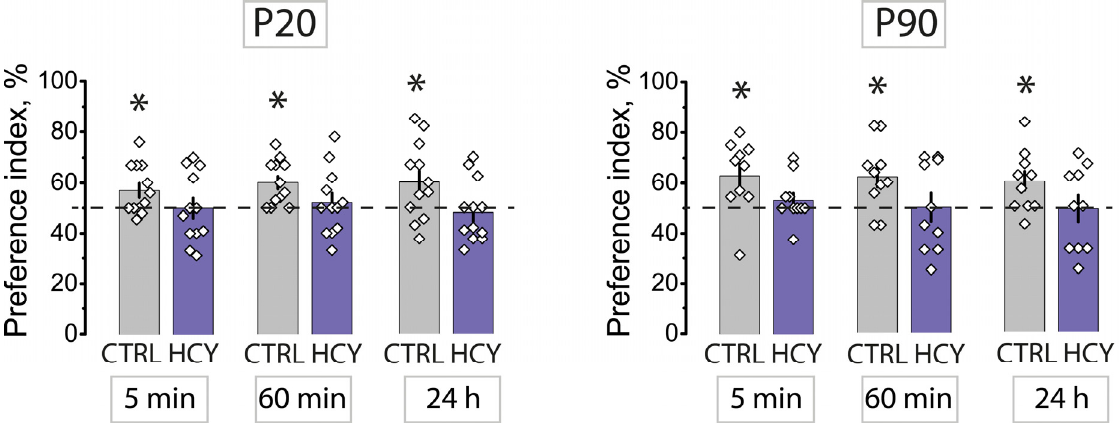
Figure 1. Diagrams showing preference index (PI) for novel objects in young (P20) and adult (P90) rats from the control ( n = 22) and HCY ( n = 22) groups. The horizontal dashed line marks a hypothetical 50% value indicating equivalent preference for new and familiar objects. All data in this and the following figures are presented as a mean ± standard error of the mean. * p < 0.05 (one-sample t -test, difference from 50% value).